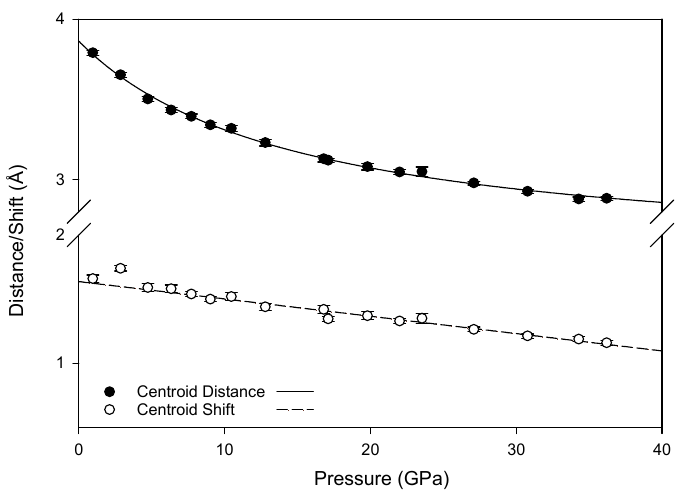
Figure A2. Ring centroid-centroid distance and shift as a function of pressure. Centroid distance is the straight line distance between the centers of the rings, shift indicates the in-plane separation between the centers of ring planes.